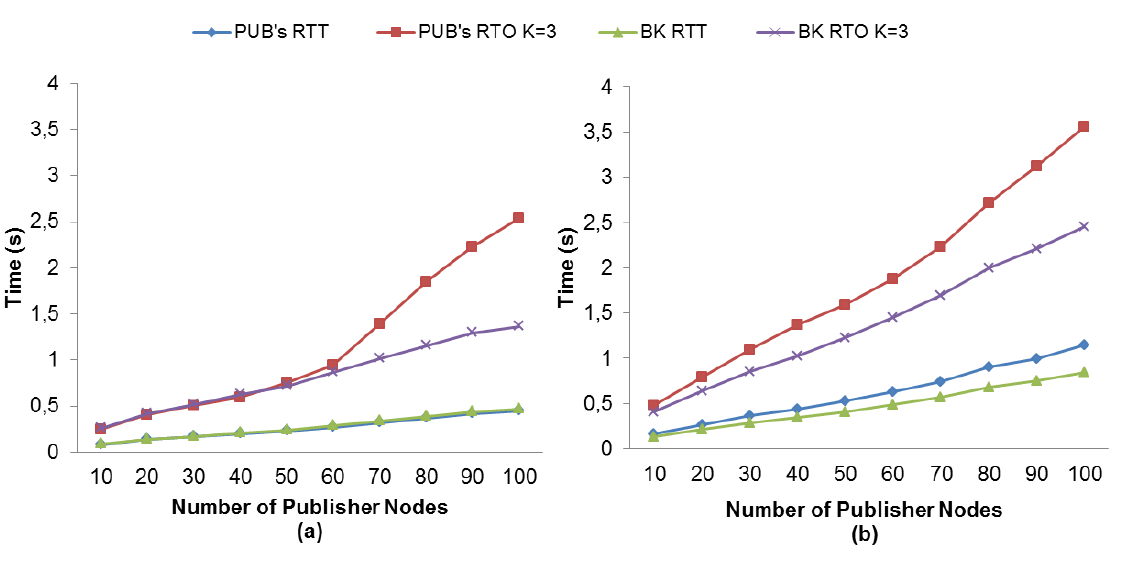
Figure 8. RTT and RTO comparisons for MQTT-S with our method without ( a ) and with ( b ) the use of MAC